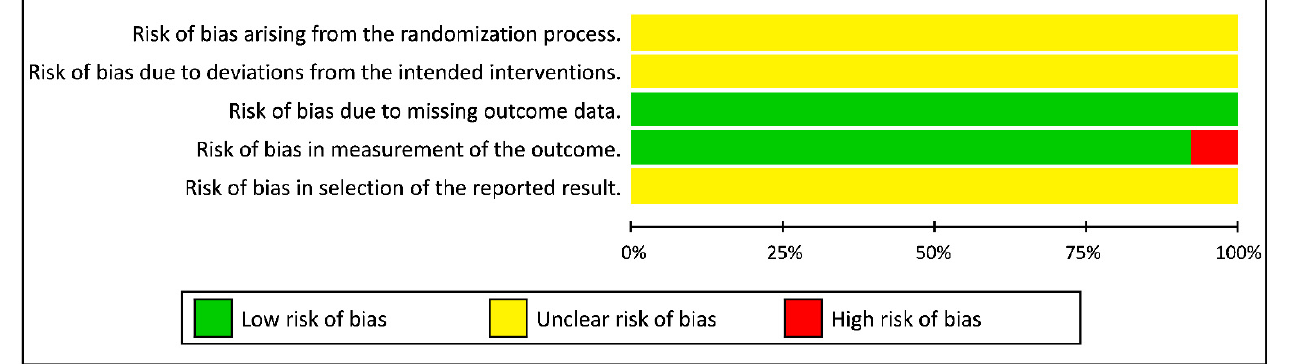
Figure 2. Risk of bias across studies.